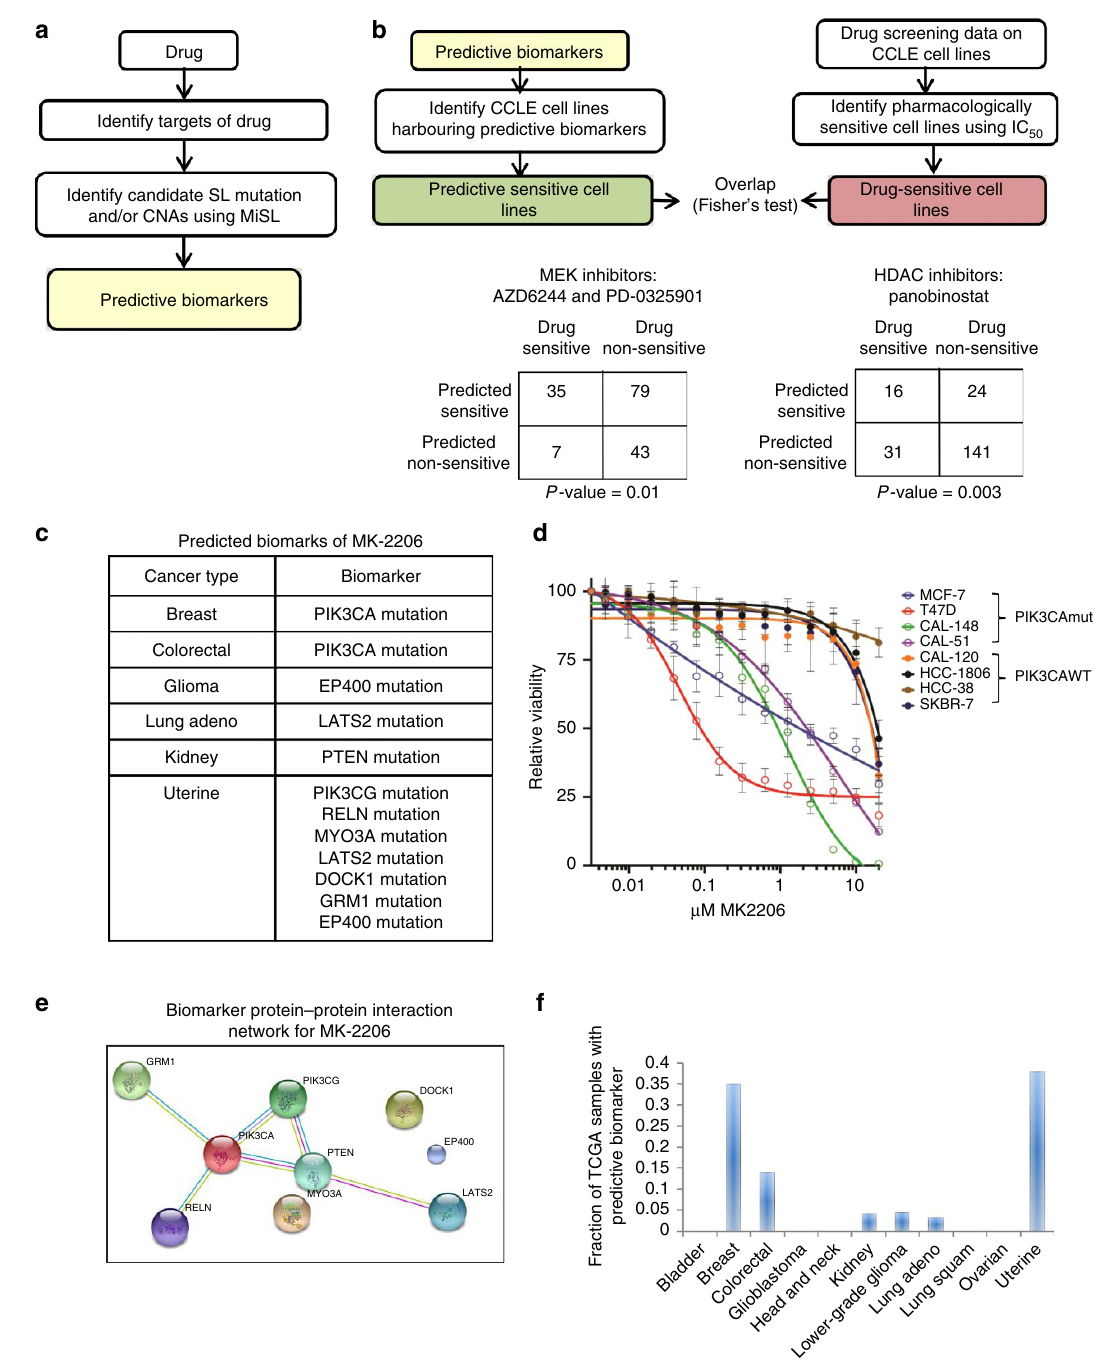
Figure 4 | MiSL identifies predictive genetic biomarkers for existing targeted therapies. ( a ) Pipeline showing the use of MiSL to identify